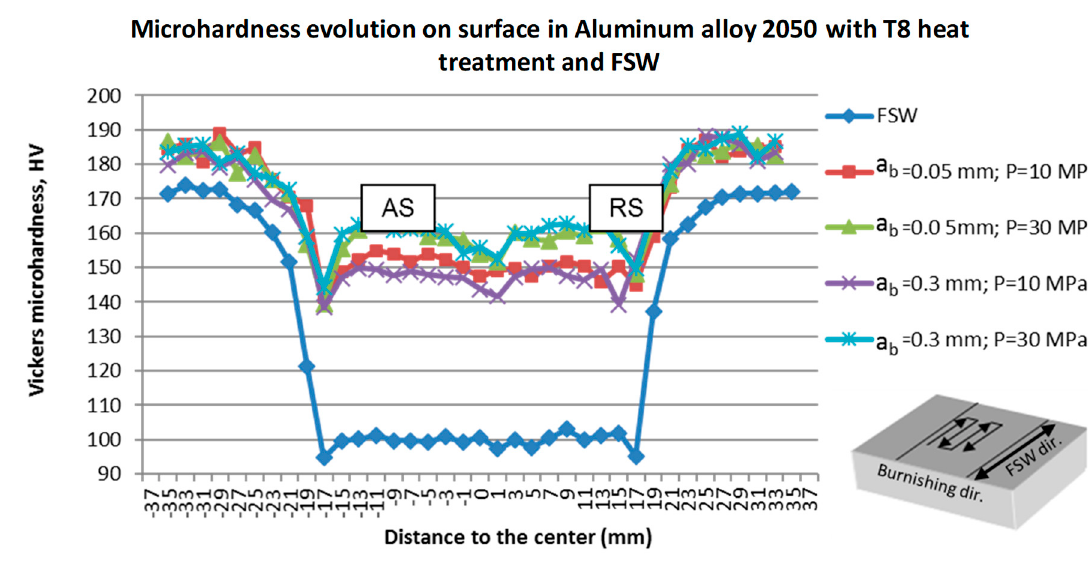
Figure 10. Microhardness evolution with burnishing applied parallel to the welding direction.